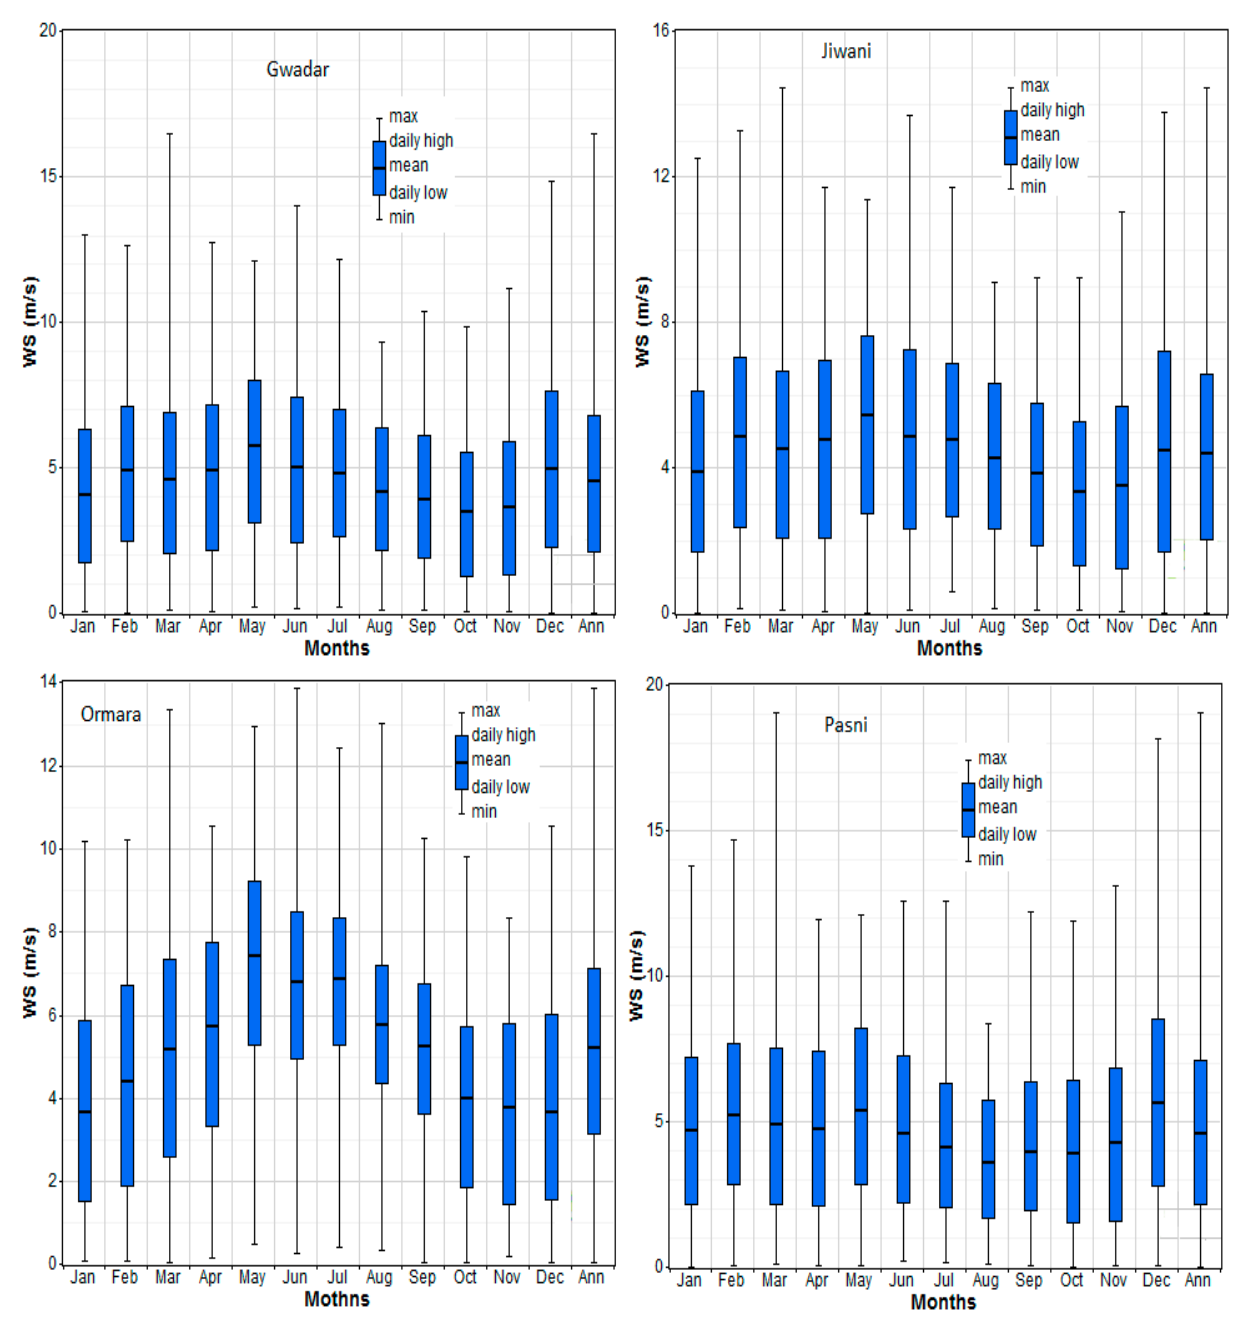
Figure 3. Daily high, low, MWS, and monthly maximum and minimum wind speeds in all regions [38]. Table 2. WS (m/s) statistics of all regions.